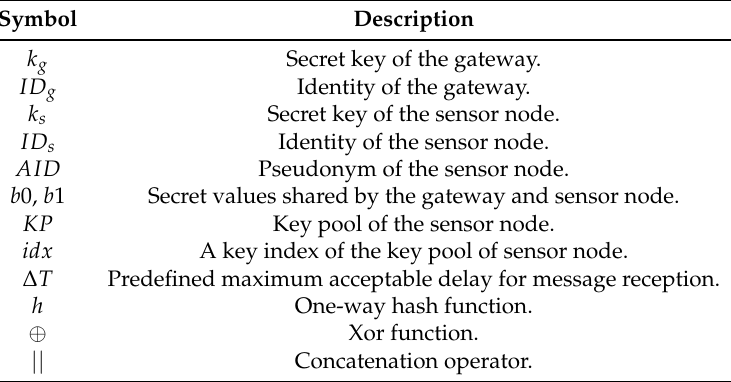
Table 1. LAKD protocol